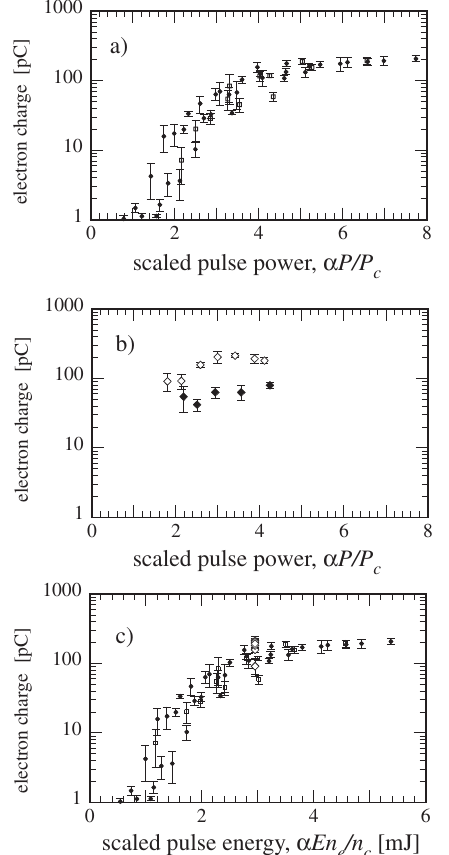
FIG. 3. (a) Electron charge ( > 4 MeV ) versus (cid:1)P=P c keeping the pulse duration constant but varying focal spot quality and plasma density (closed circles) or total pulse energy and plasma density (open squares) but keeping pulse duration constant. (b) Electron charge versus (cid:1)P=P c varying pulse duration while keeping plasma density and energy in focal spot constant. (c) Data from (a) and (b) plotted versus (cid:1)En e =n c . Each data point is an average of five shots and the error bars represent 1 standard